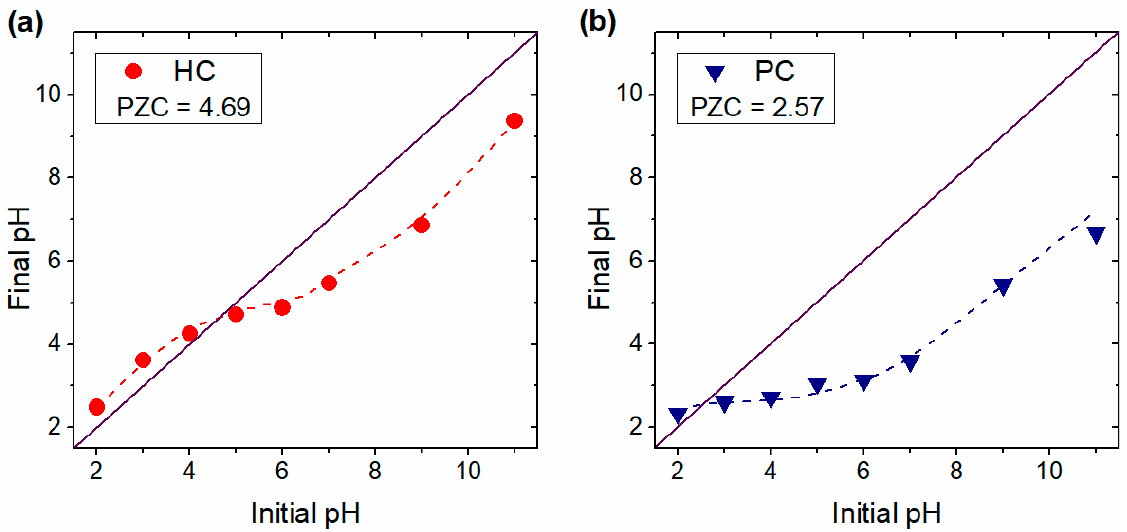
Figure 2. PZC measurement for ( a ) HC and ( b ) PC.